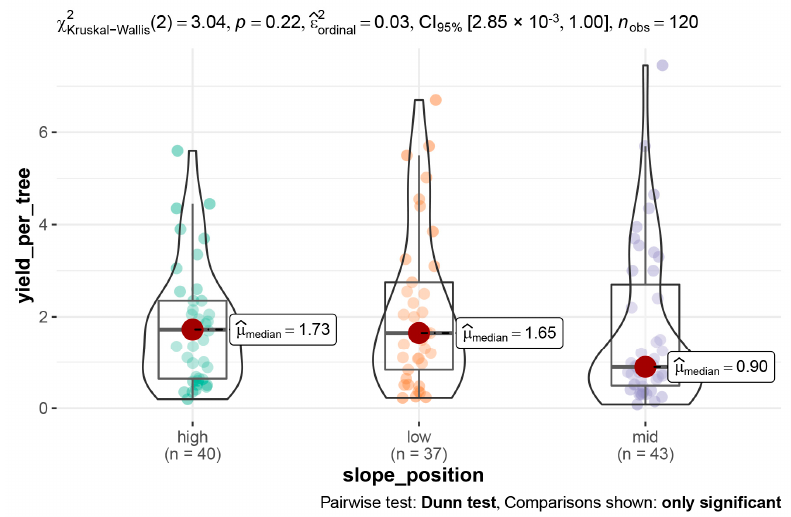
Figure A2. Comparison of green nut yield per tree (kg) among the different slope positions (high, low and mid). There is no significant difference among slope positions ( p > 0.05).